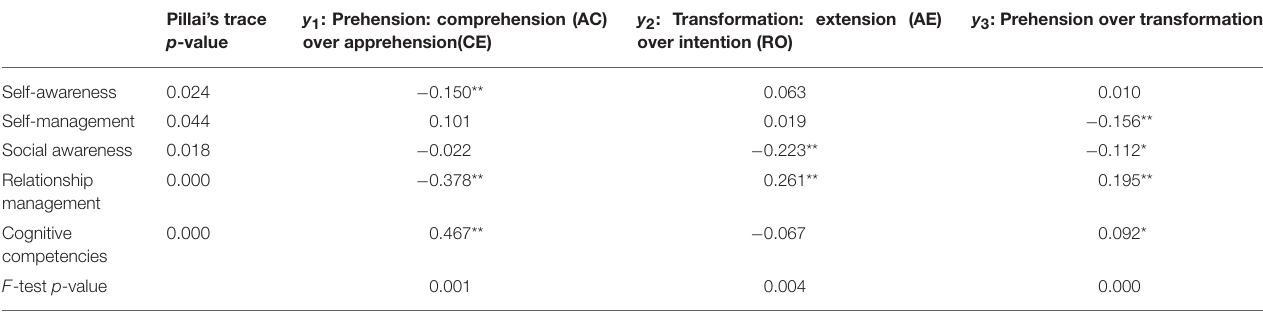
TABLE 3 | Effects from theoretical clusters of social and emotional competencies on learning style log ratios and joint tests’ p -values. Pillai’s trace p